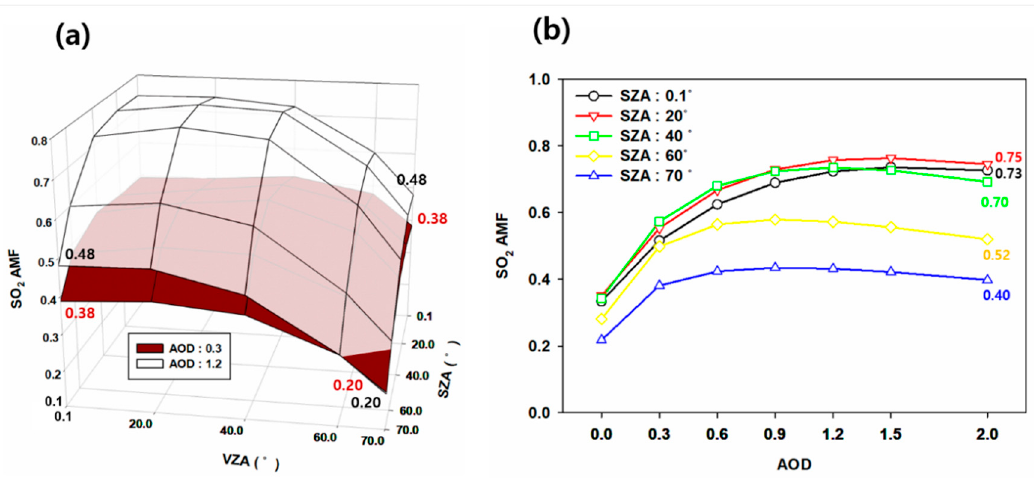
Figure 5. Changes in PBL SO 2 AMF ( a ) as a function of SZA and VZA at low and high AOD, and ( b ) a function of SZA and AOD under conditions of VZA = 40 ◦ , RAA = 45 ◦ , surface reflectance = 0.05, O 3 as a function of SZA and AOD under conditions of VZA = 40°, RAA = 45°, surface reflectance = 0.05, VCD = 275 DU, wavelength = 318 nm, and APH = 0 O 3 VCD = 275 DU, wavelength = 318 nm, and APH = 0 km.